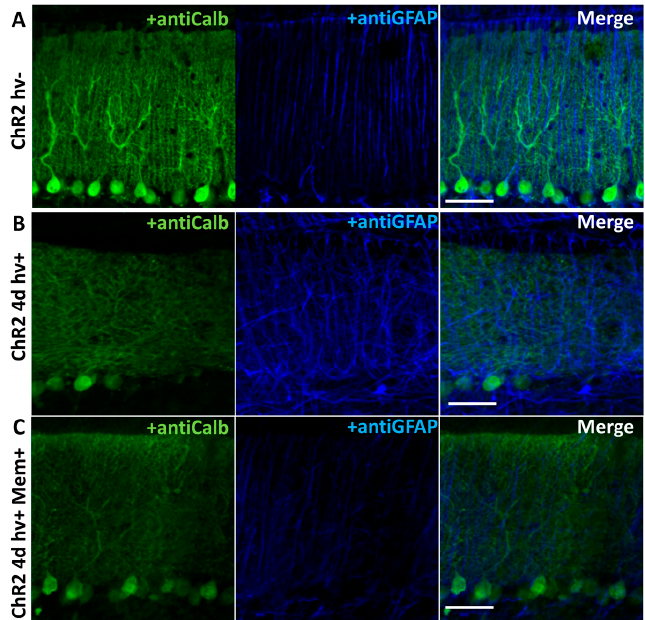
Figure 2. Memantine prevents changes in cerebellar cells morphology caused by chronic photostimulation of BGChR2. Confocal images of cerebellar cortex labeled with anti-Calbindin (PCs marker) and anti-GFAP (BG marker). ( A ) Animals without photostimulation (hv − ). ( B ) Animals with chronic photostimulation, (hv+). ( C ) Animals with chronic photostimulation (hv+) treated with memantine (Mem+). Table 1. Influence of memantine on basic passive electrophysiological and AMPA receptor-mediated EPSCs in PC in mice injected with AVV GFAP-ChR2-mKate after chronic photostimulation. Kinetics of PF EPSCs (10%–90% rise time and decay time constant) and their amplitudes are shown. Paired-pulse facilitation (PPF) of PF EPSCs was analyzed using two stimuli with an interstimulus interval of 50 ms. Ratios of PPF were measured as the second EPSC amplitude normalized to the first one. One-way ANOVA followed by Tukey’s post hoc test indicates significant effects in Capacitance and Amplitude. n —number of cells/number of animals, * p < 0.05; ** p < 0.001; † p < 0.001.